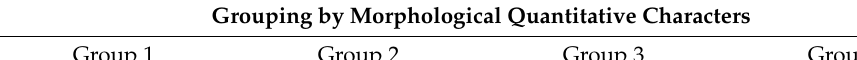
Table A1. Grouping by morphological and ecogeographical quantitative characters for the Ecuado- rian collection of